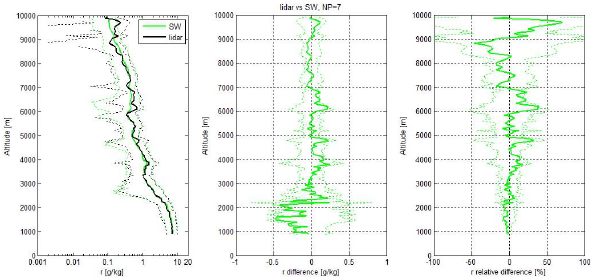
Fig. 6. Similar to Fig. 5 but comparing IGN-LATMOS Raman li- dar measurements to Meteolabor Snow White measurements (7 pro- files).